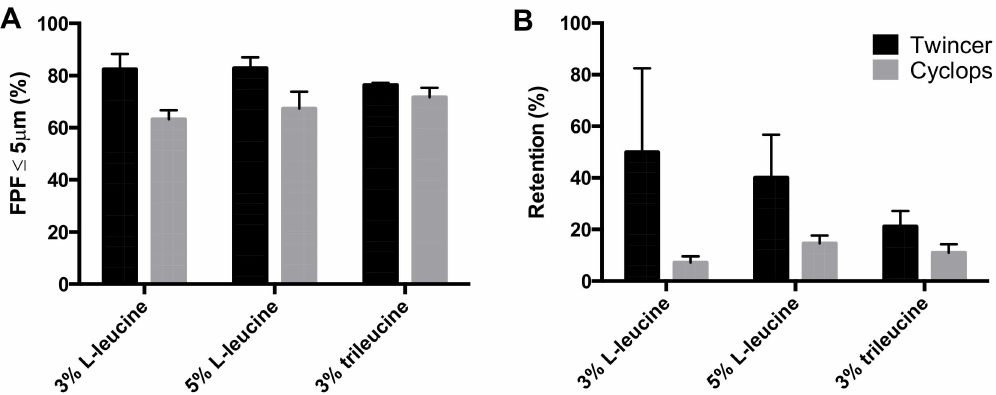
Figure 7. Comparison between the Twincer ® and Cyclops ® DPI with three isoniazid formulations dispersed at 4 kPa ( n = 3, average ± SD). ( A ) shows the FPFs of the delivered dose from laser diffraction analysis, while ( B ) shows the retained powder mass as a fraction of the nominal dose (i.e., 50 mg). The L-leucine formulations are spray-dried at 120 ◦ C, while the trileucine formulation is spray-dried at 40 ◦